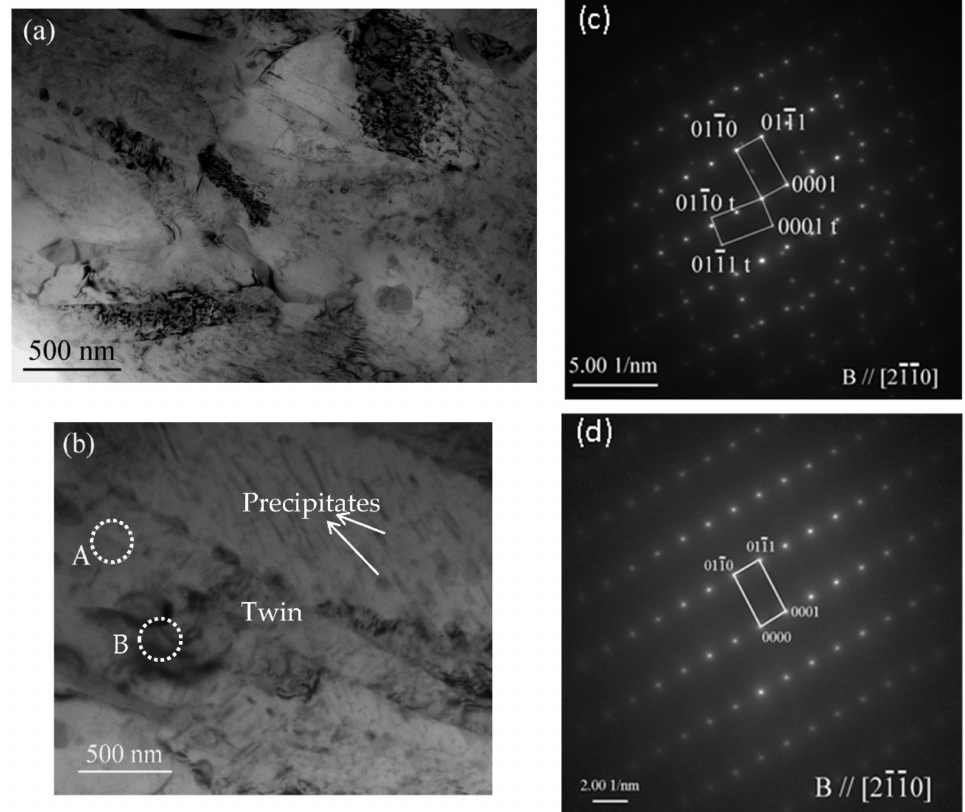
Figure 10. ( a , b ) illustrate the TEM bright field images of the sample subjected to 175 MPa and then aged at 170 ◦ C for 1 h and the sample subjected to simultaneous loading and aging under the same condition, respectively; ( c , d ) show the corresponding SAED patterns of point A and B,